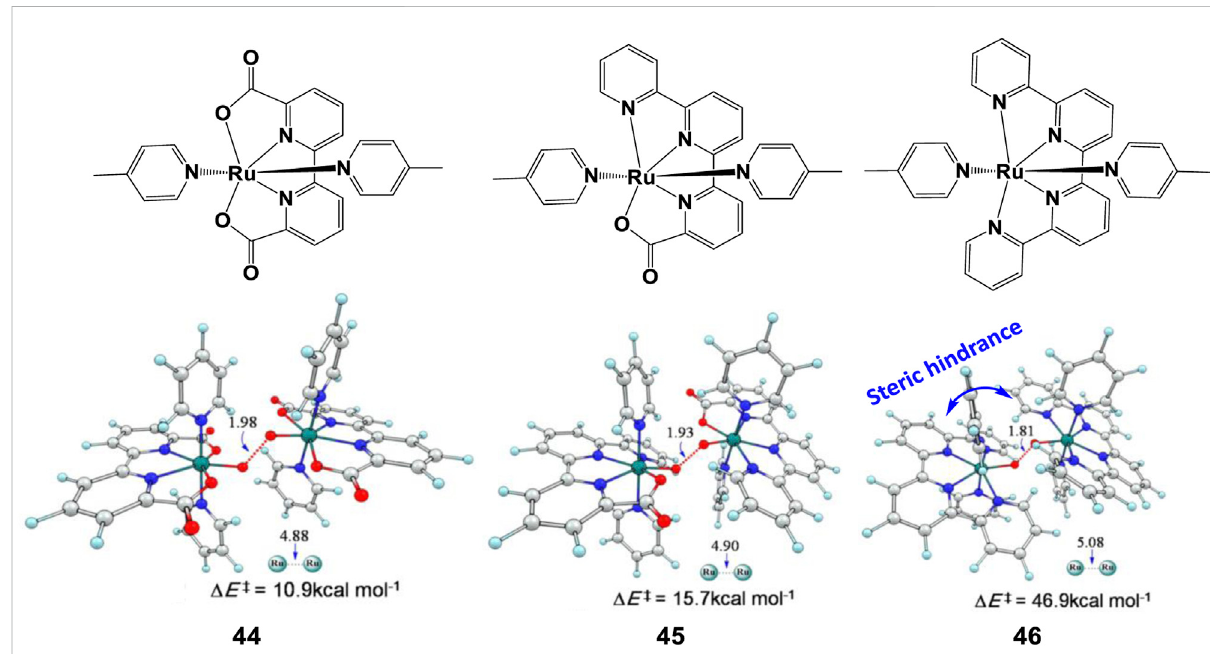
FIGURE 18 Chemical structures of complexes 44 – 46 and transition-state structures of O − O bond formation catalyzed with corresponding complexes following the I2M mechanism, adapt with permission from Inorg. Chem. 2014, 53, 7,130 – 7,136. Copyright 2014 American Chemical Society.